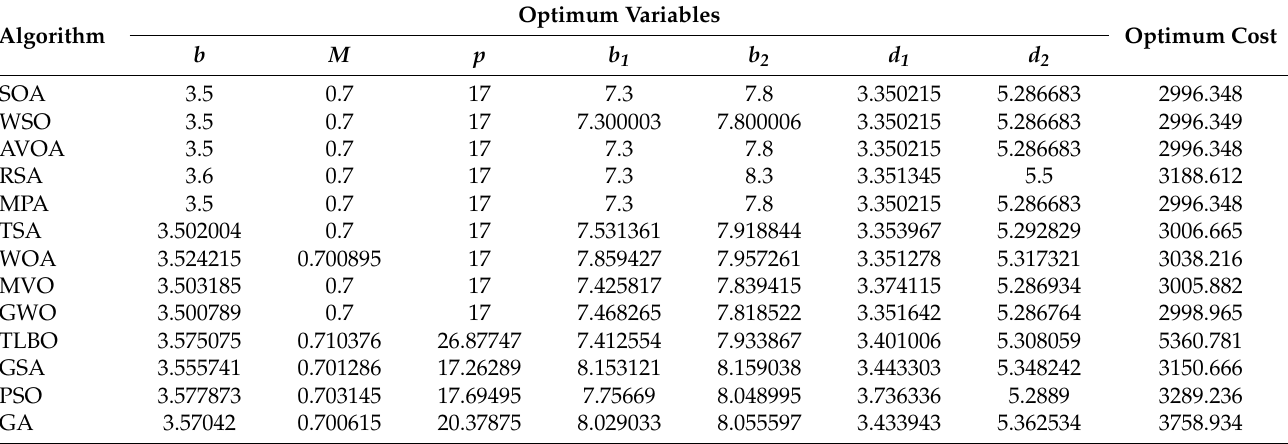
Table 11. Performance of optimization algorithms on the speed reducer design problem.